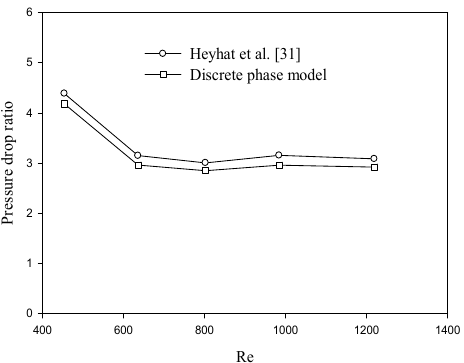
Figure 4. The ratio of pressure drop for Al 2 O 3 -water nanofluid versus Reynolds numbers at dp = 40 nm and Φ = 0.01.